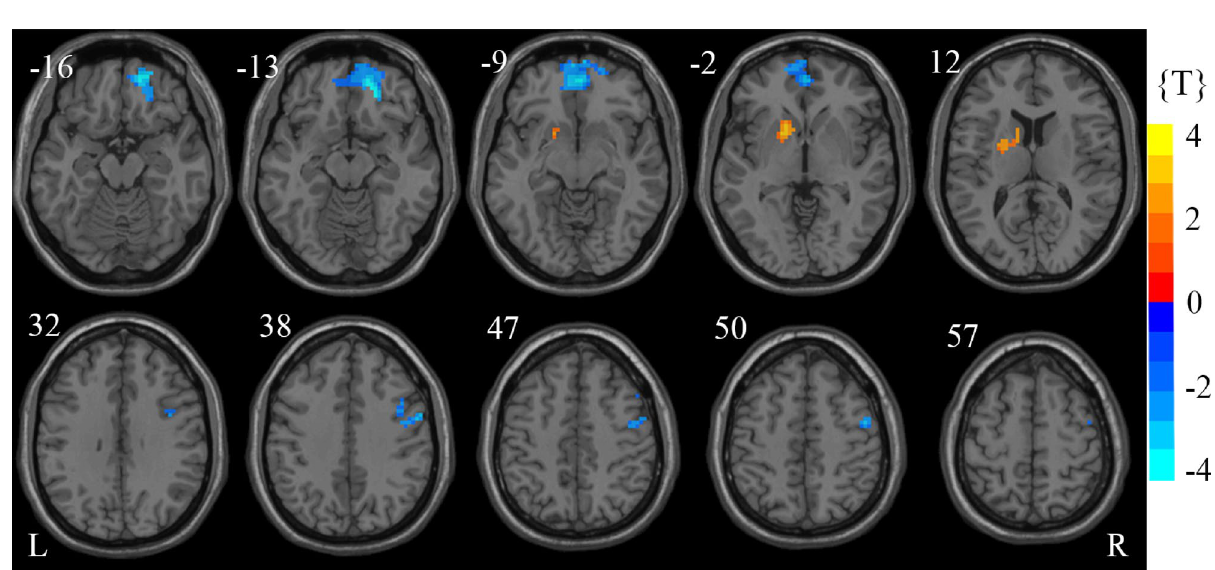
Figure 3. Statistically significant differences in regional homogeneity (ReHo) between children with GHD and healthy controls ( p < 0.05, AlphaSim corrected). The figure was presented using the free DPABI software. Cold and hot colors in the color bar indicate decreased and increased ReHo, respectively, in children with GHD. The number above each image refer to the z-plane coordinates of the Montreal Neurological Institute space. GHD growth hormone deficiency, L left, R